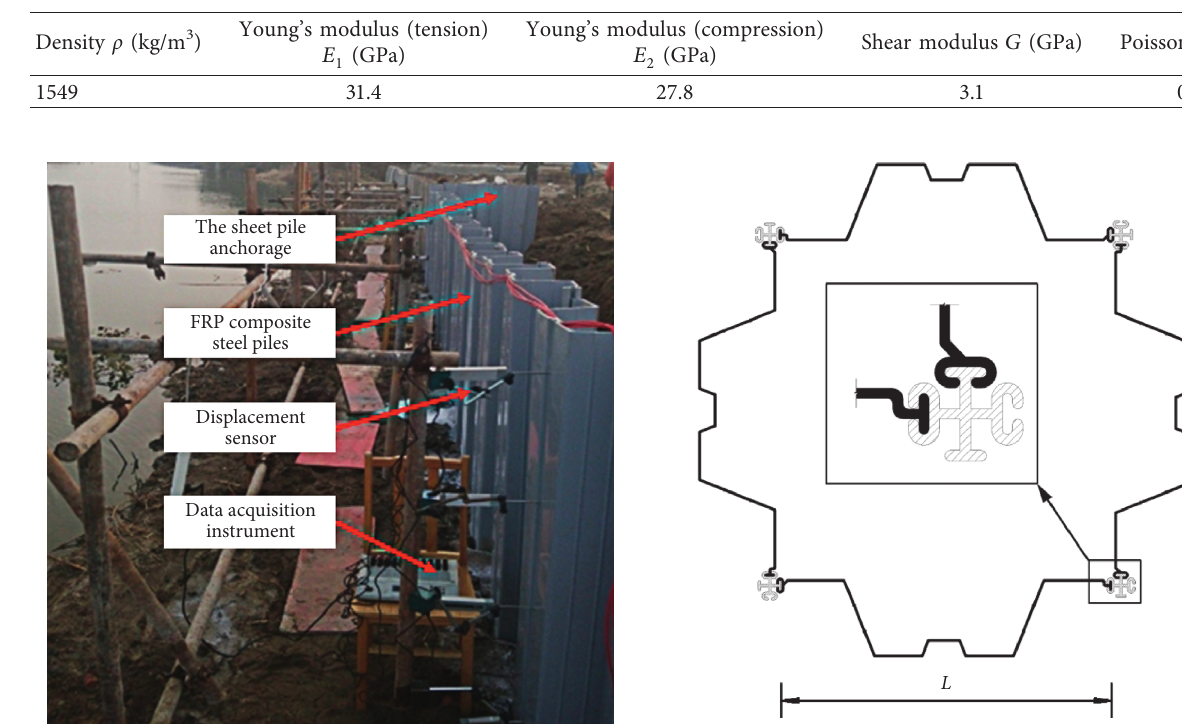
Table 2: Basic material properties of the FRP composite sheet piles.